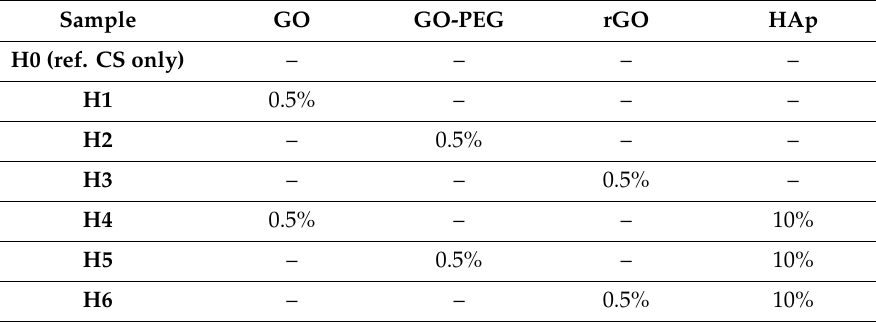
Composition of the systems used to obtain gradient hydrogels (GO—graphene oxide, GO-PEG—poly(ethylene glycol) grafted graphene oxide, rGO—reduced graphene